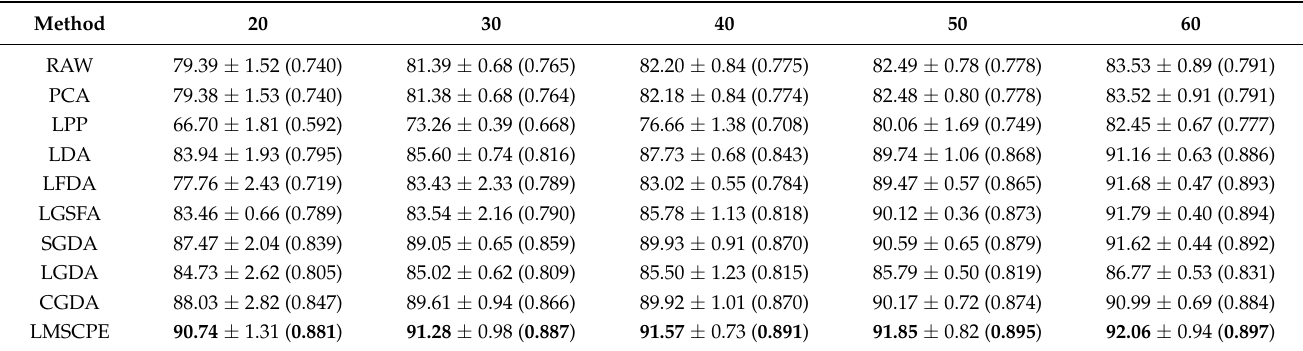
Table 2. Classification results of each method with different training sample sizes on the LongKou dataset [OA ± STD (%)(KC)]. (OA—overall classification accuracy, STD—standard deviation, KC—kappa coefficient, and the best results of a column are marked in bold).